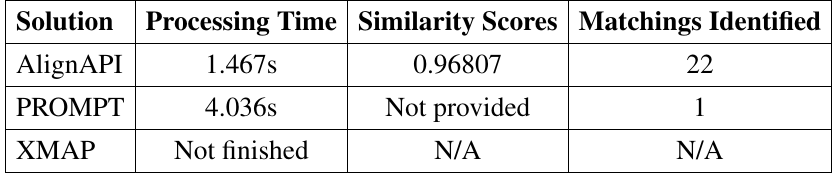
Table 2. Processing time, Similarity Scores, and Matchings assessments